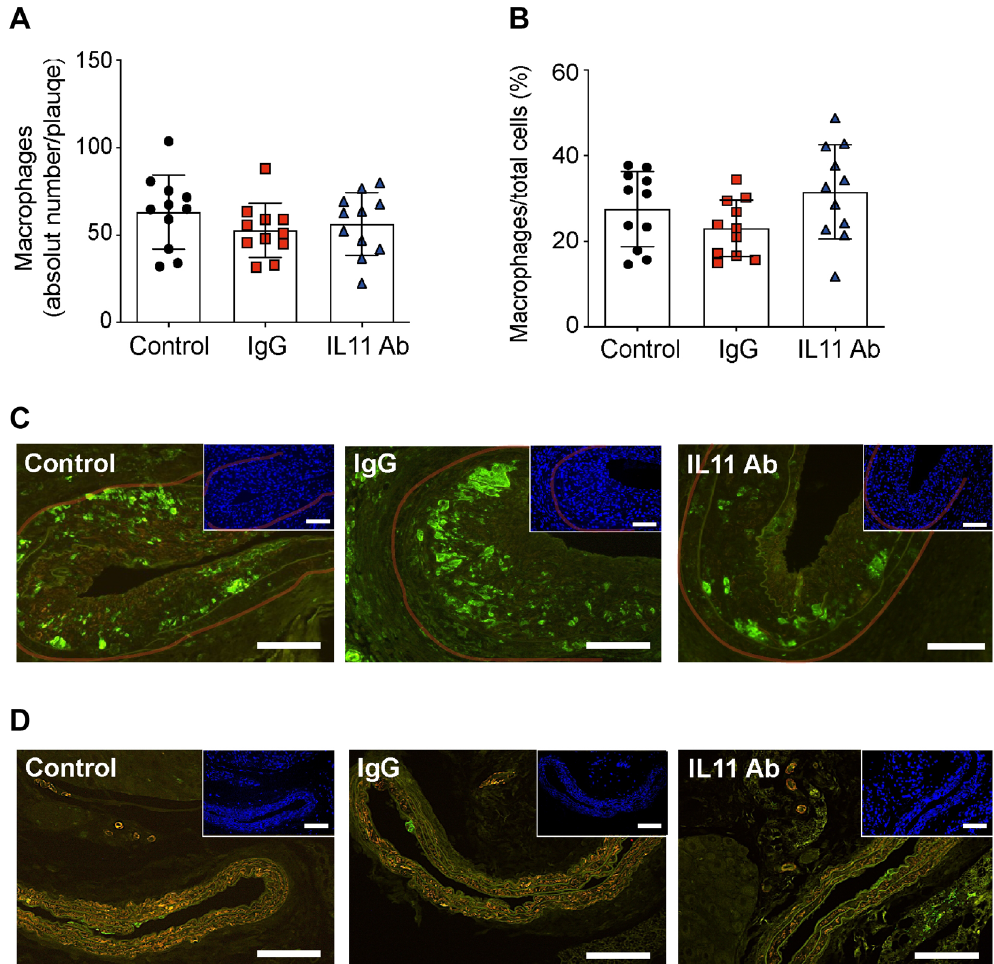
Figure 4. The effect of anti-IL-11 antibody (X203) treatment on macrophage infiltration. ( A ) Macrophages per injury-related plaque (N = 11/group, One-way ANOVA, Tukey’s multiple comparison test, Values ± SD). ( B ) Macrophage proportion of all cells (N = 11/group, One-way ANOVA, Tukey’s multiple comparison test, Values ± SD). ( C ) Representative images of Mac2 immunofluorescence staining and corresponding DAPI staining (insets) (scale bar 100 µm). Transparent red-lines were traced to delineate the injury-related plaque area used for quantifications. ( D ) Representative images of Mac2 staining in the right uninjured carotid arteries and corresponding DAPI staining (insets) (scale bar 100